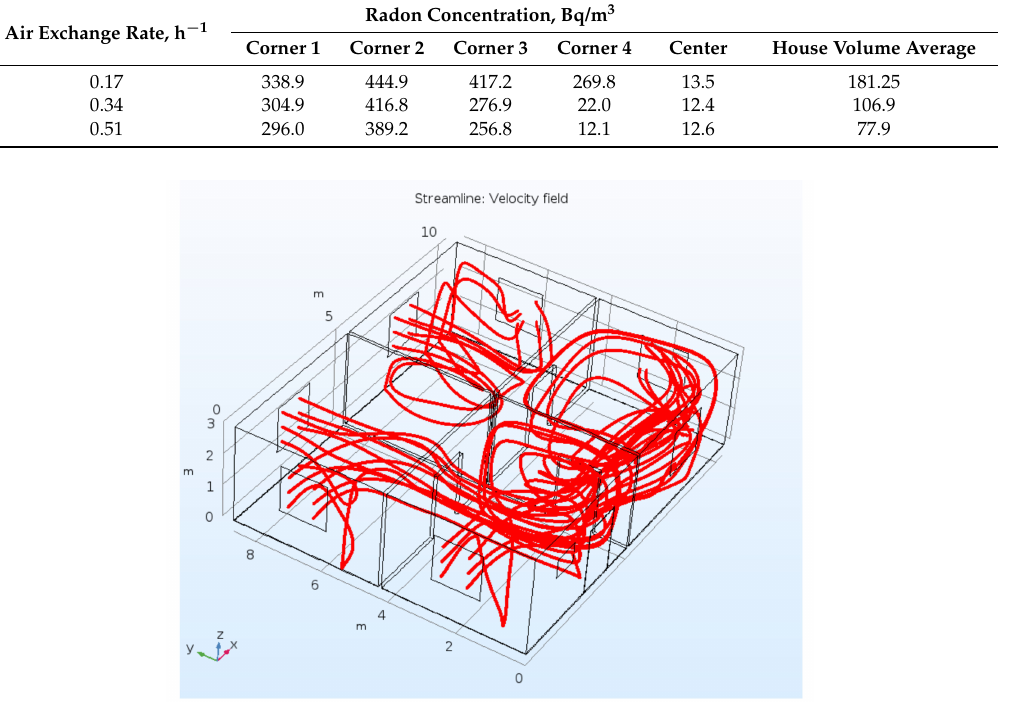
Figure 4. Velocity streamlines, λ = 0.17 h − 1